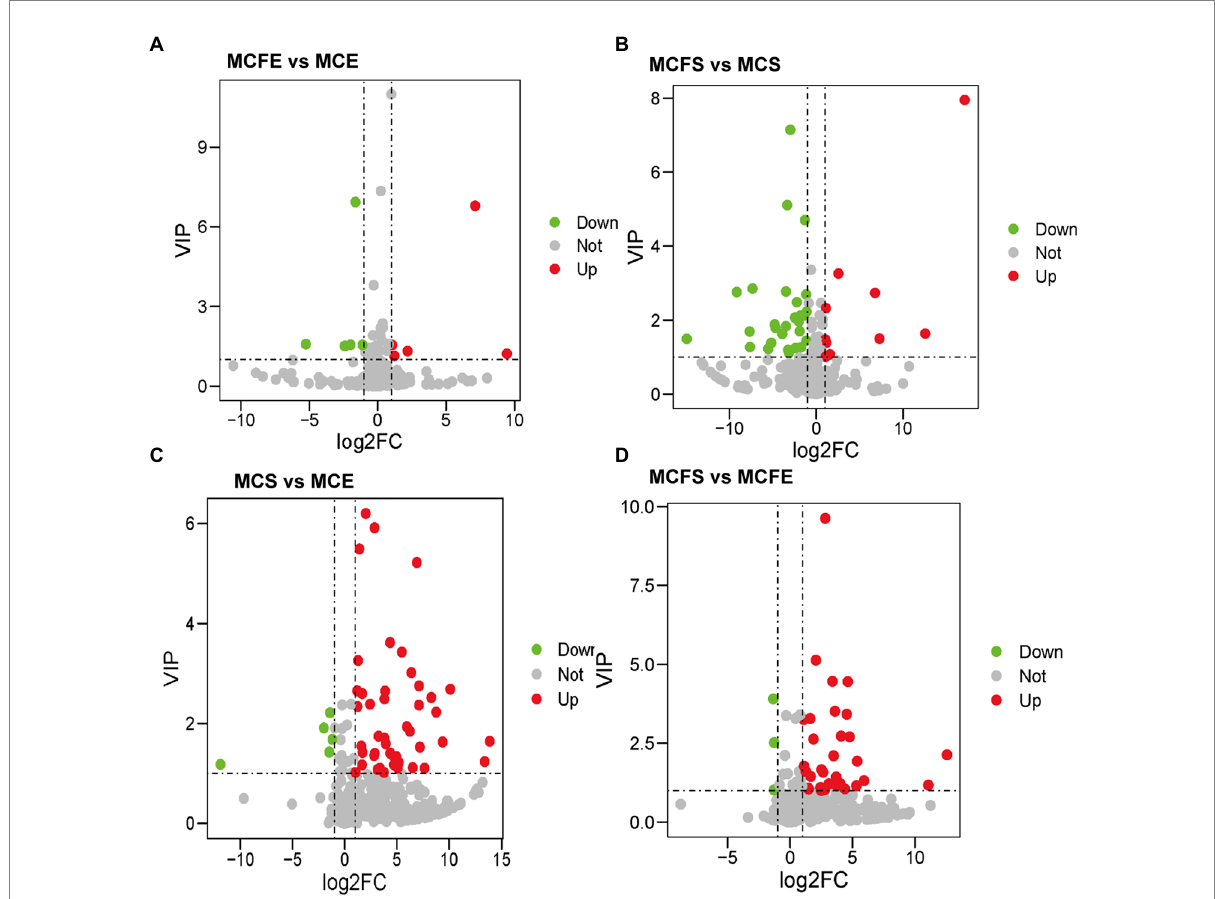
FIGURE 4 Differential metabolites in pairwise comparison among four MaE groups: volcano plots of differential metabolites in MCFE vs. MCE (A) ; MCFS vs. MCS (B) ; MCS vs. MCE (C) ; MCFS vs. MCFE (D) . MCE, MC-producing strain at exponential phase; MCFE, MC-free strain at exponential phase; MCS, MC-producing strain at stationary phase; MCFS, MC-free strain at stationary